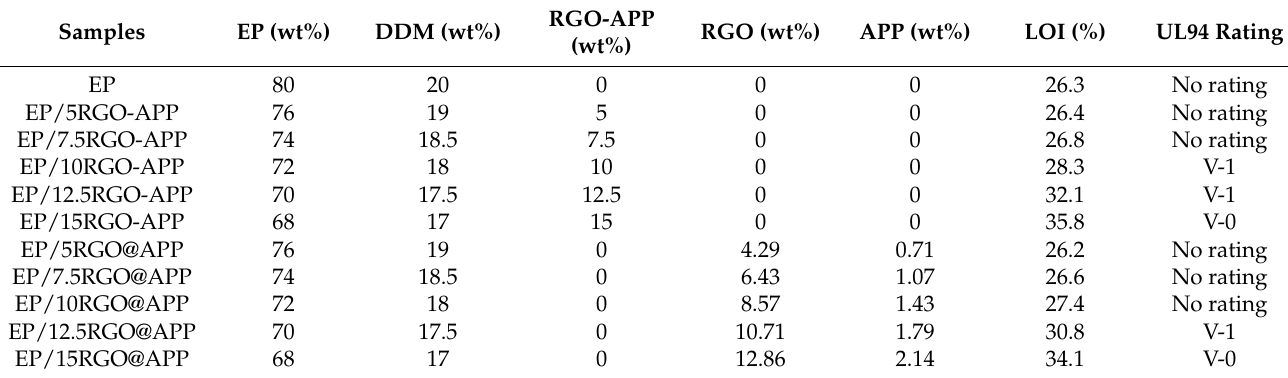
Table 1. Formulations and flammability of the EP composites.